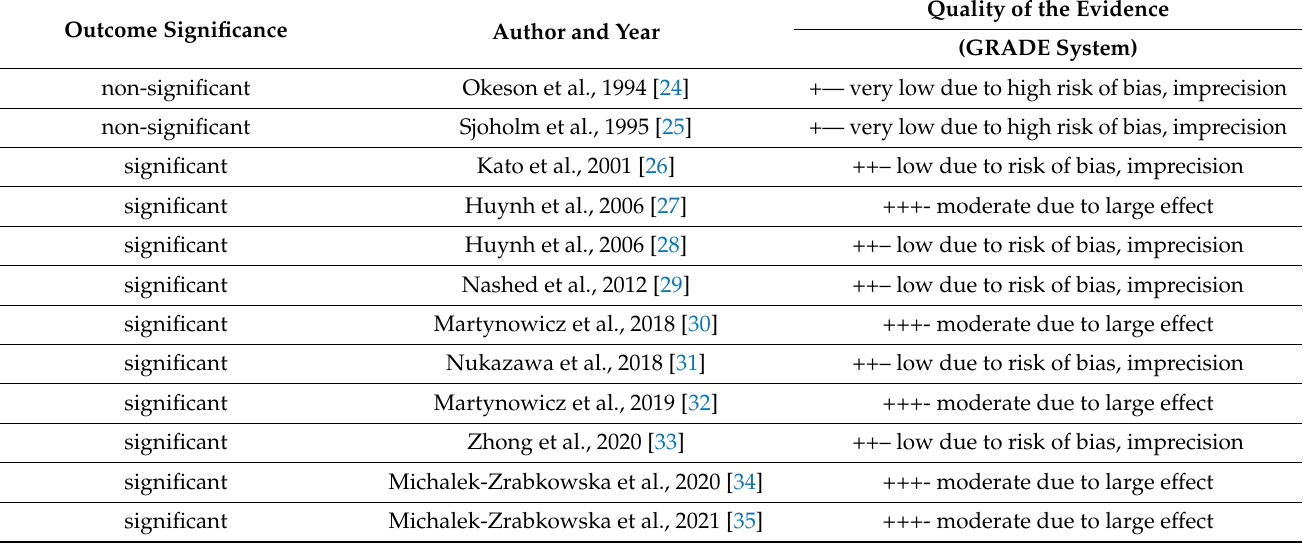
Table 2. Quality of the evidence of the included